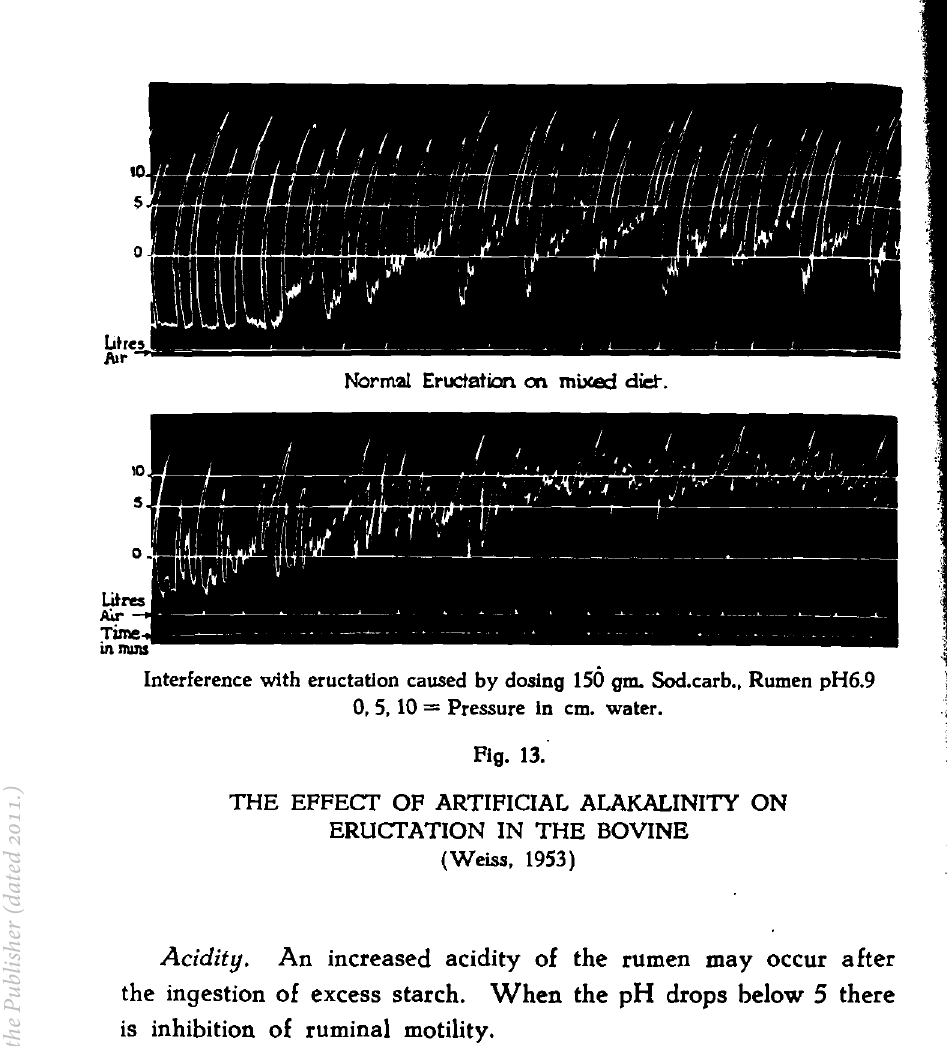
THE EFFECf OF ARTIFICIAL ALAKALINITY ON ERUCfATION IN THE BOVINE (Weiss,